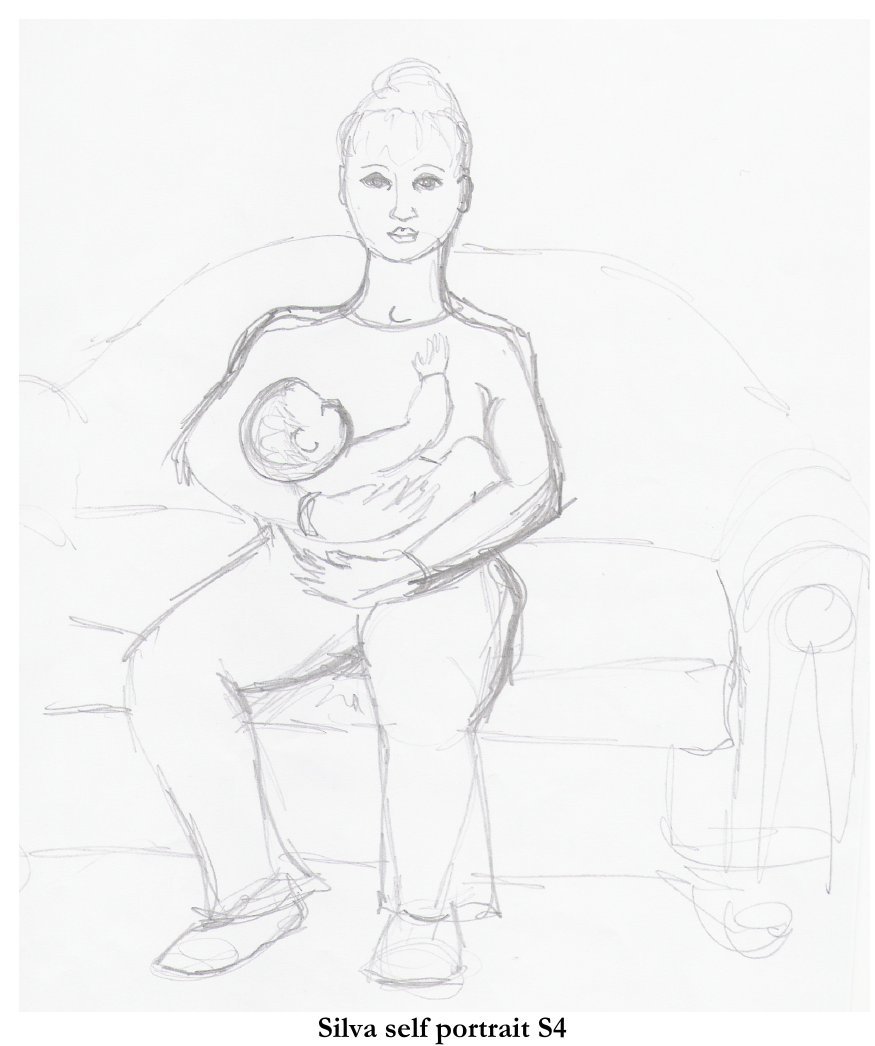
Agné Matulaité, ‘I’ve Got You Under My Skin’: The Embodied Relationship with the Baby Within Studies in the Maternal, 4(1), 2012,